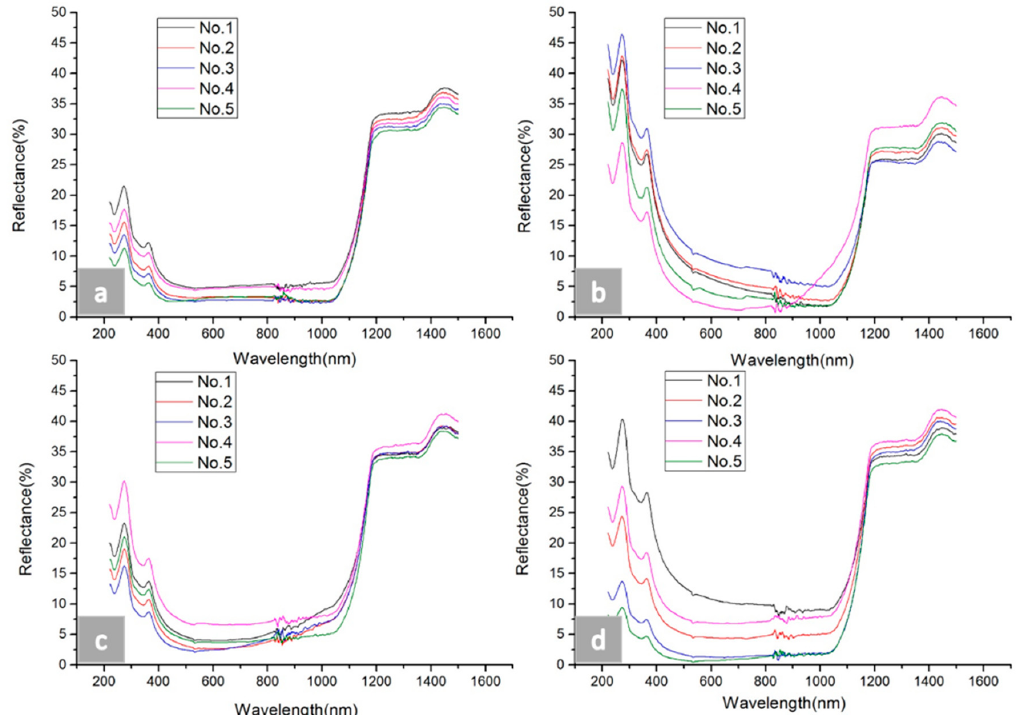
Figure 8. The hemispherical reflectance spectra of the black silicon micro-nano hybrid structures obtained for the different pits size structures. ( a ) The reflectance results of the five samples with #5 depth size, ( b ) the reflectance results of the five samples with #6 depth size, ( c ) the reflectance results of the five samples with #7 depth size, and ( d ) the reflectance results of the five samples with #8 depth size.